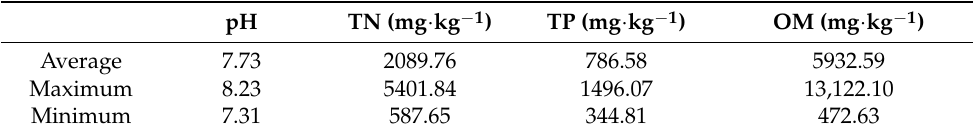
Table 3. Descriptive statistics of physical and chemical properties of the surface sediments from the Huafei River.